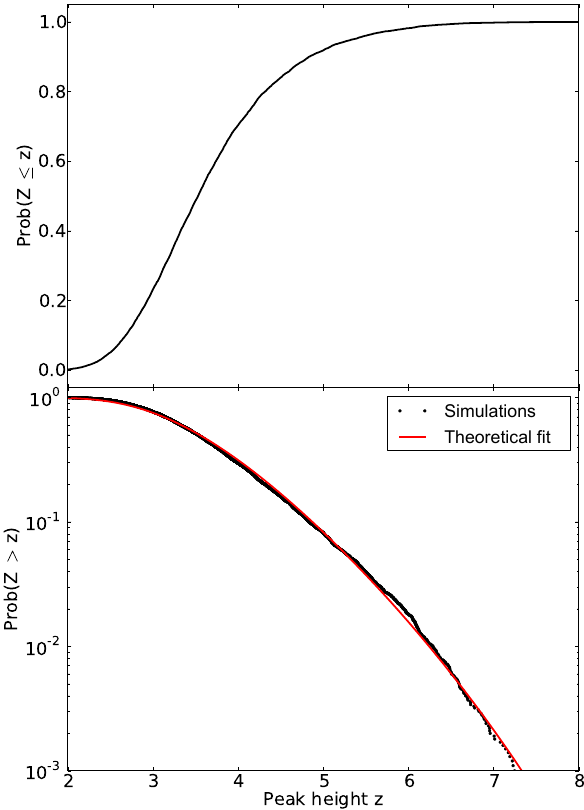
Figure 4. Distribution for peak heights z determined using random values from a Gaussian distribution as input for the calculation of LSP (for details see Sect. 3). The upper panel shows the empiri- cal CDF, thus, the probability that there is a height Z smaller or equal to z . The FAP (probability that a height Z larger z occurs just by chance) is shown in the lower panel. The simulation results are shown in black and a fit to the theoretical curve from Eq. (2) is shown in red. Note the logarithmic scale of the y axis of the lower panel. This calculations are done for a data sampling same as that of the time series from 1988 to 2015 including data gaps. The fit leads to a number of independent frequencies N i = 32 .